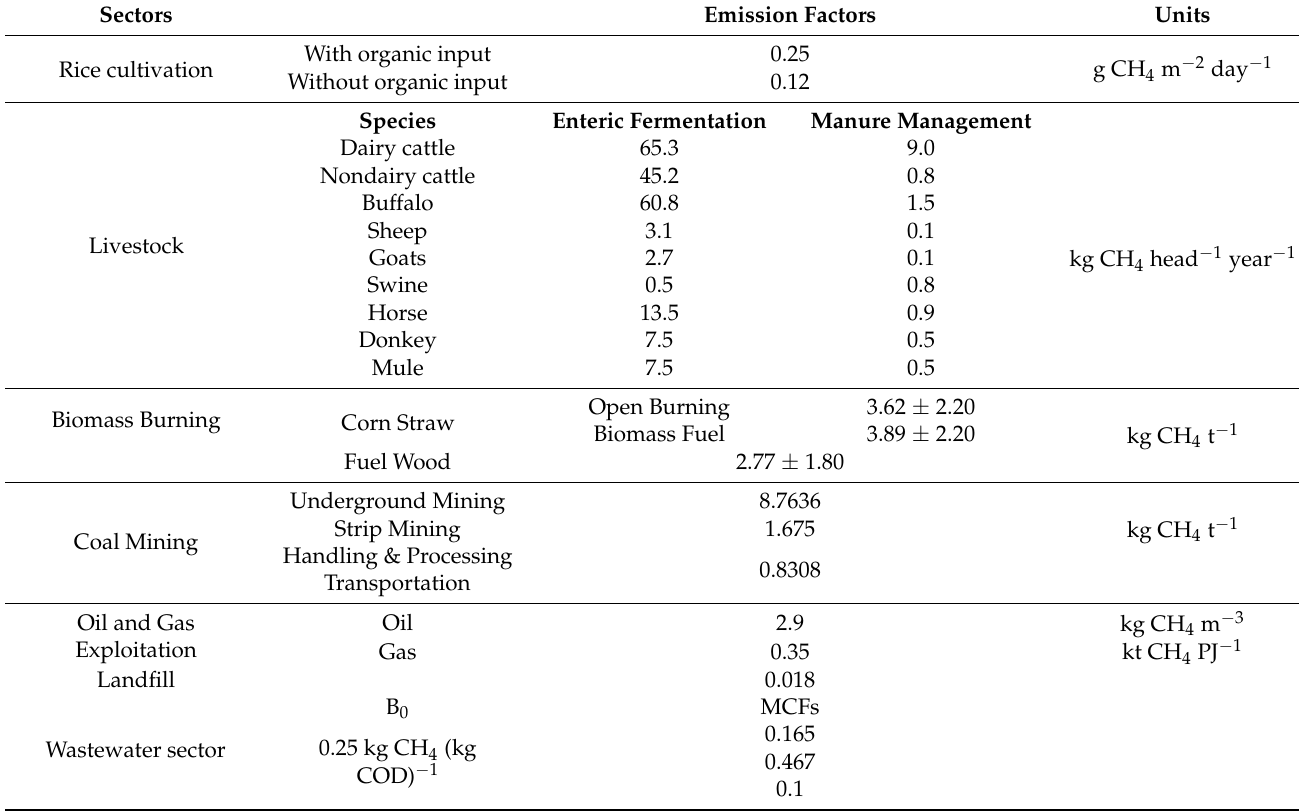
Table 1. Emission factors of